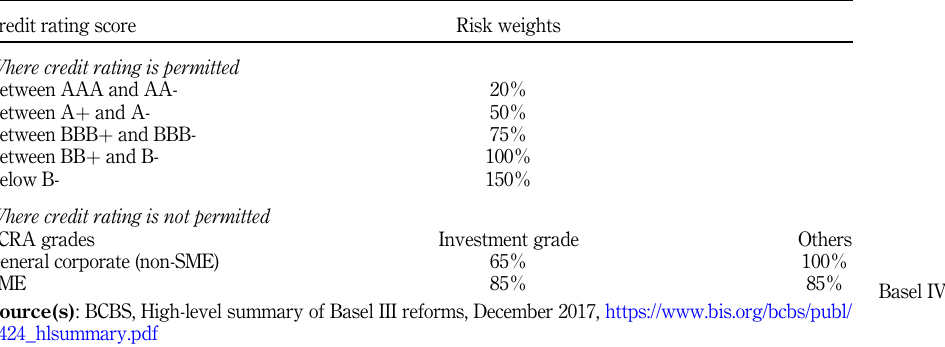
Table 2. Basel IV risk